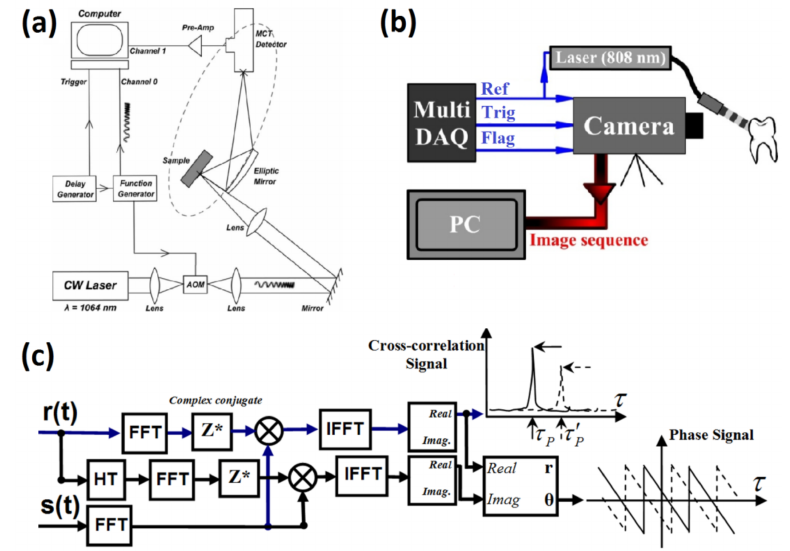
Figure 4. Schematic presentation of TWR experimental setups using ( a ) a single detector [23] and ( b ) an infrared camera [23], ( c ) signal processing block diagram of TWR